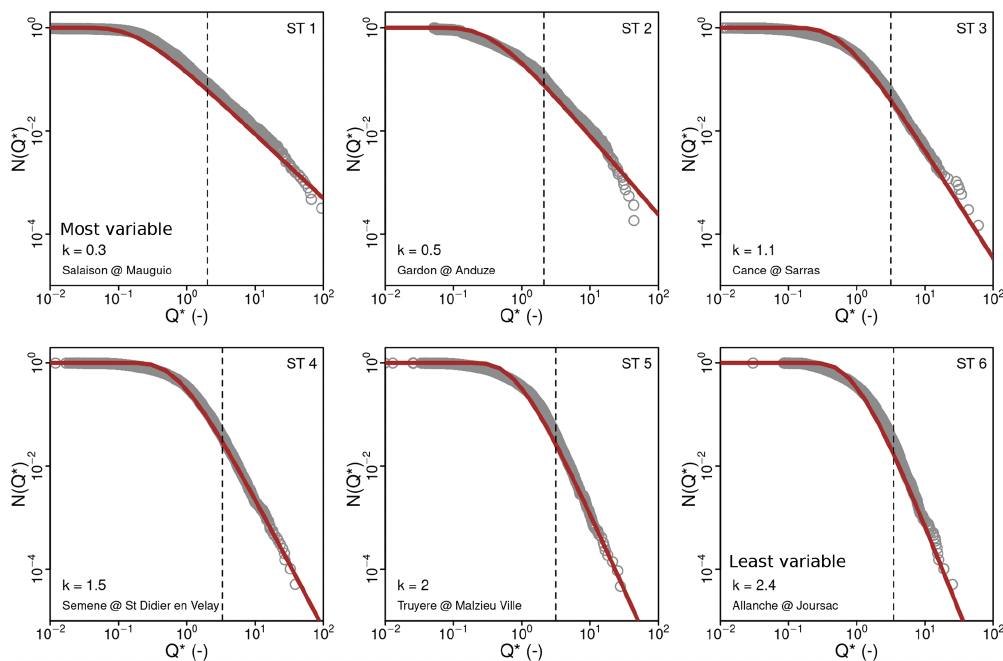
Figure 3. Normalized daily discharge exceedance frequency for selected gauging stations (dark grey circles, see Fig. 1b for location). Dark red lines are fitted inverse gamma distributions (Eq. 12). The corresponding value of the discharge variability parameter k is indicated in each panel. The vertical dashed lines indicate for each station the lower bound of the normalized discharge values used to fit the power law (Clauset et al., 2007).